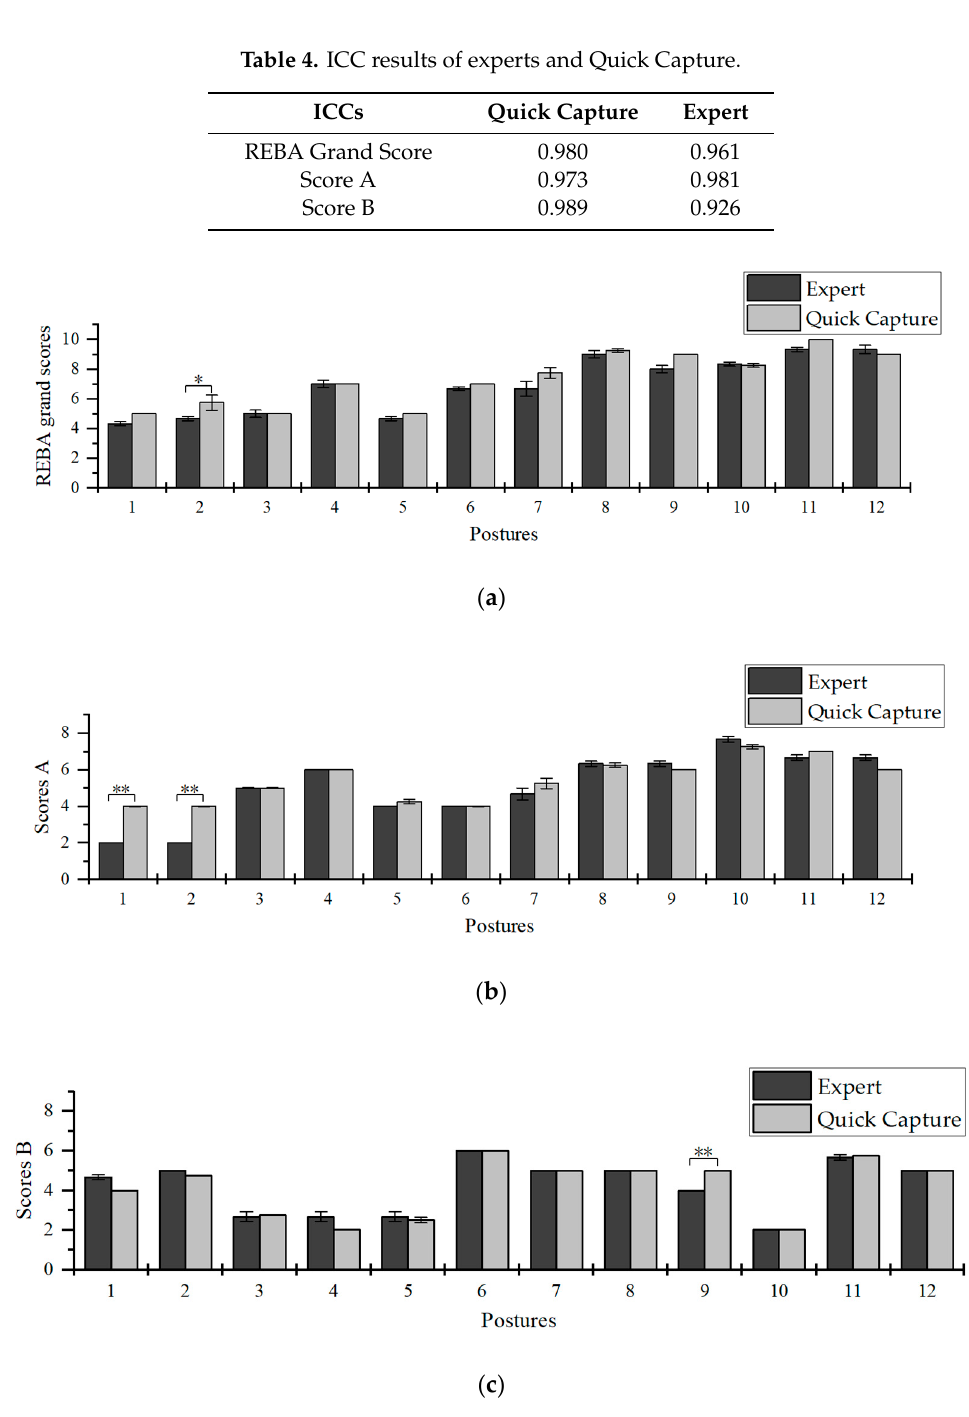
Figure 10. Comparison of REBA scores between experts and Quick Capture system evaluation. REBA grand scores ( a ), scores A ( b ), scores B ( c ). **: significant difference ( p < 0.01); *: significant difference ( p < 0.05).